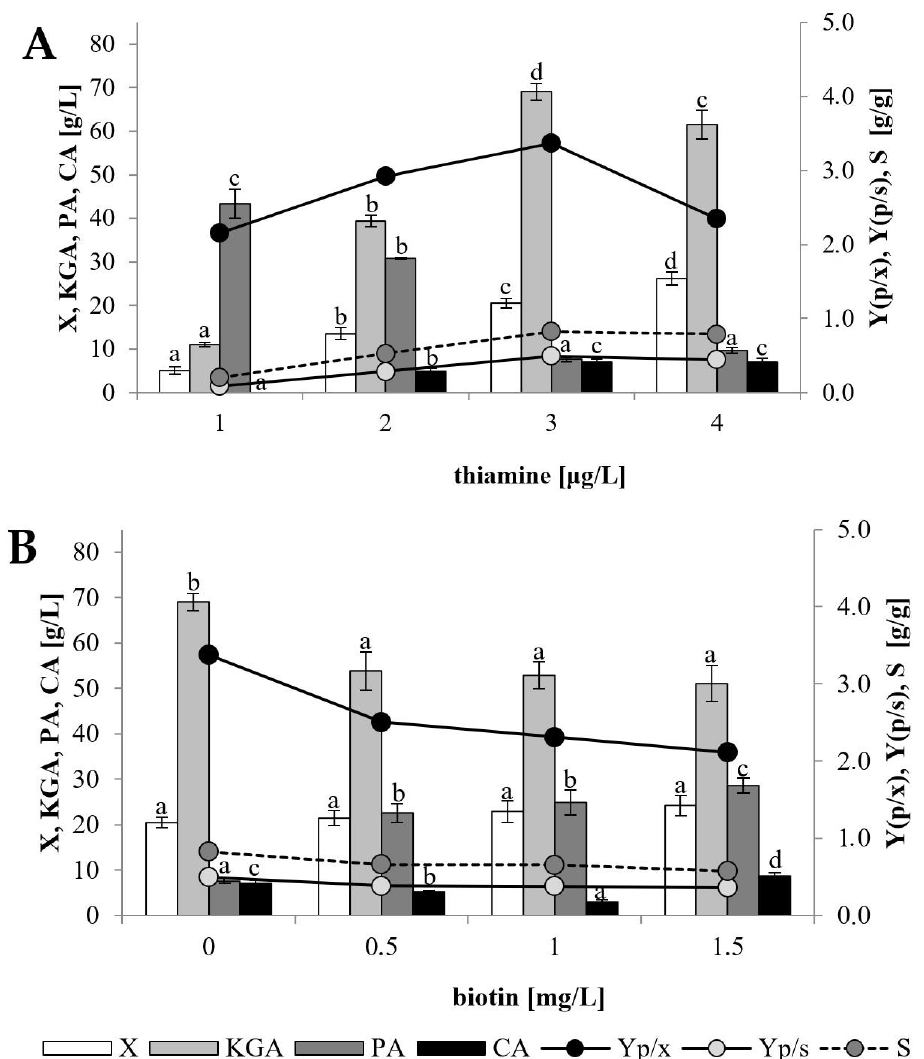
Figure 3. Impact of thiamine ( A ) and biotin ( B ) on the yeast growth and acids formation during KGA biosynthesis performed by Y. lipolytica CBS 146773 in mixed glycerol/oil-based media. Culture conditions: 20% Ca(OH) 2 , pH 3.5, 800 rpm, 3 µ g/L of thiamine ( B ). Abbreviations: X—biomass; KGA— α -ketoglutaric acid; PA—pyruvic acid; CA—citric acid; Y—yield of KGA with respect to biomass formed (p/x) and utilized substrates (p/s); S—selectivity of KGA relative to sum of acids formed (KGA/(KGA + PA + CA)). Mean values for a specific product concentration marked with different letters (a, b, c, . . . ) differ significantly at p ≤ 0.05. Error bars indicate standard